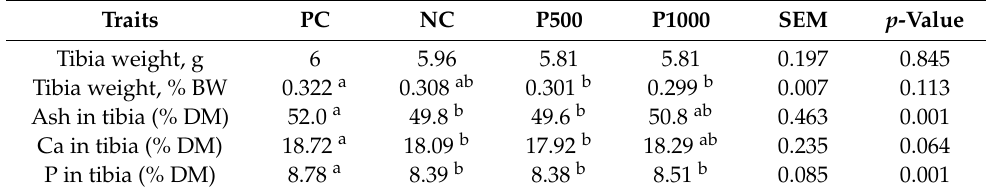
Table 5. Effect of dietary phytase inclusion on bone mineralization traits of laying hens at 31 weeks of age. Traits